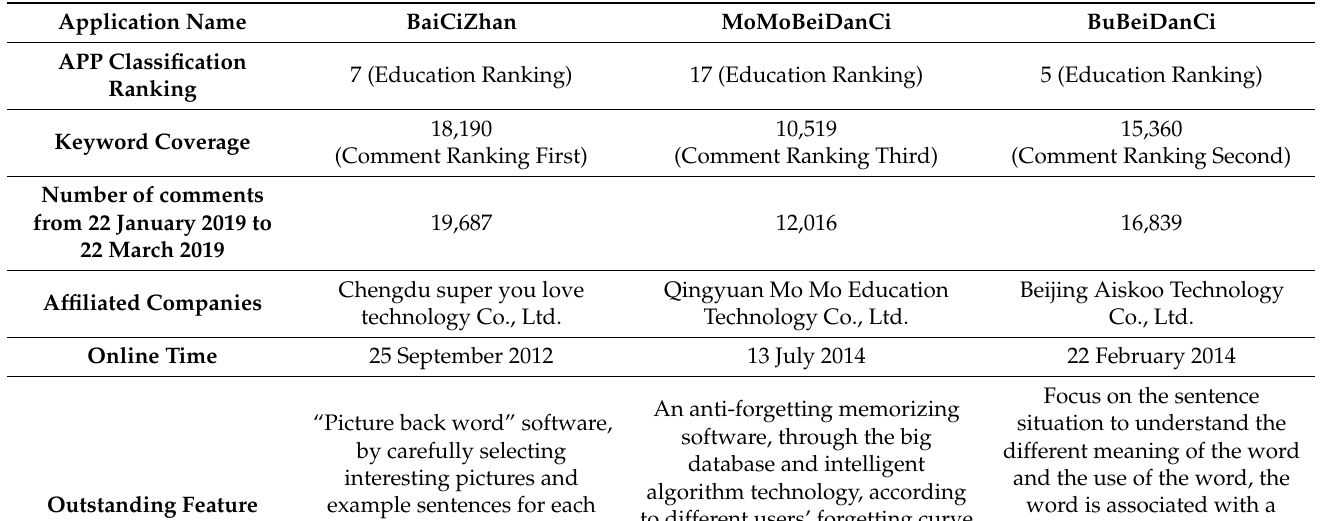
6 of 27 Table 1. Selected English Vocabulary APP information.